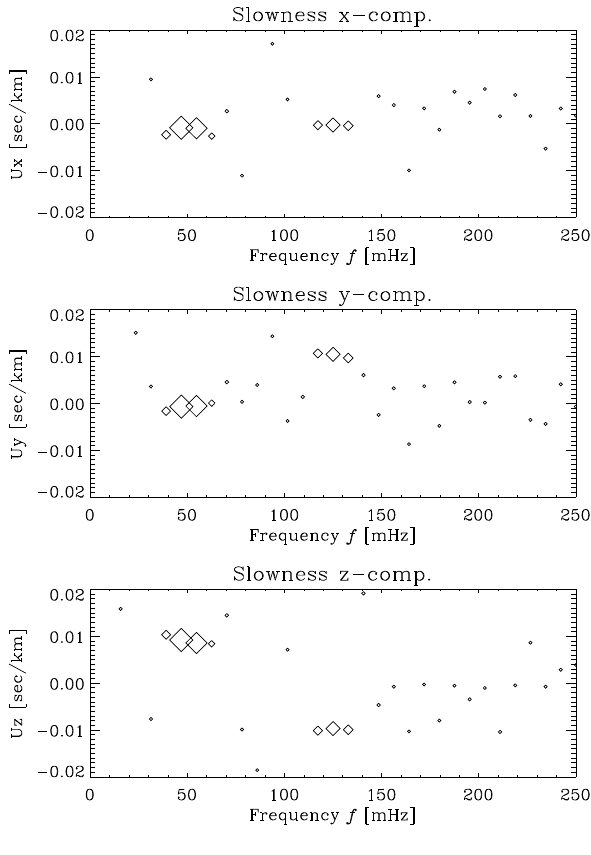
Fig. 3. Demonstration of the wave surveyor technique. The com- ponents of the slowness vector u are given as functions of the fre- quency f = ω/ 2 π . For each frequency, the area occupied by the plotting symbol is a measure of the signal power given by the largest eigenvalue. Only the frequency bands associated with the coherent part of the model signal yield significant power. The smaller dia- monds that show much scatter are associated with the contribution of the noise term to the model